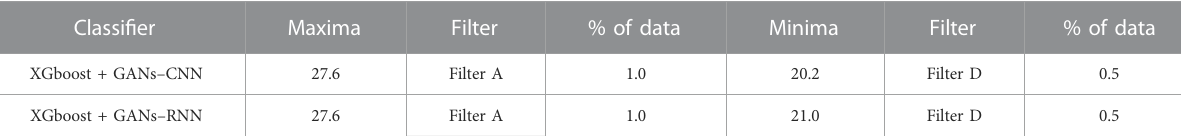
TABLE 12 Enrichment Ratios of OPRK1 on the dataset consisting of features as shown in Table 11 with training size of